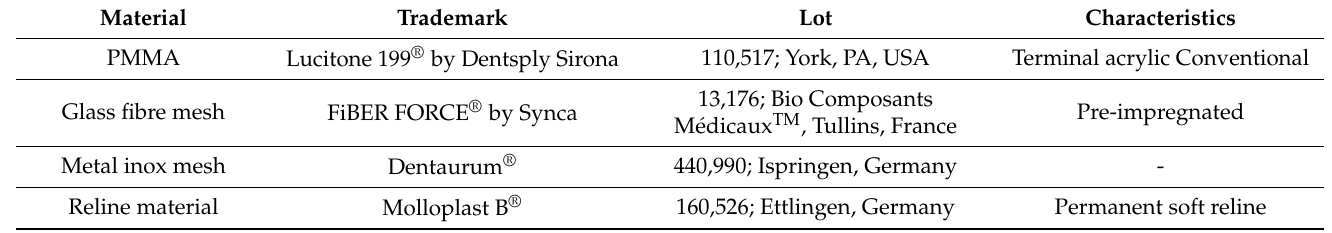
Table 1. Trademarks of the selected materials.